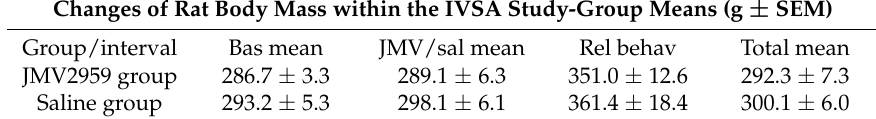
Table 1. Changes of rat body mass within the IVSA study. The body mass changes are represented as group means (JMV2959 group N = 12, Saline group N = 8) during the chosen periods of the experiment as follows: mean of the last eight days before pretreatment (Bas mean), mean of the three pretreatment days (JMV/sal mean), the day of the relapse-like behavior test (Rel behav), mean of 8 baseline days + 3 pretreatment days + day of relapse-behavior testing (Total mean). Means of the rat groups are presented ± SEM. The statistical significances are described below the table. Changes of Rat Body Mass within the IVSA Study-Group Means (g ± SEM) Group/interval Bas mean JMV/sal mean Rel behav Total mean JMV2959 group 286.7 ± 3.3 289.1 ± 6.3 351.0 ± 12.6 292.3 ± 7.3 Saline group 293.2 ± 5.3 298.1 ± 6.1 361.4 ± 18.4 300.1 ± 6.0 Two-way ANOVA RM difference between JMV2959 vs. saline groups: F1,18 = 0.43, p = 0.519 (n.s.), effect of time: F11,198 = 33.45, p < 0.001 (difference of relapse-like behavior in both JMV2959 and saline groups vs. other parameters), time × group interaction: F11,198 = 0.17, p = 0.1 (n.s.); Baseline = mean of 8 days, JMV/sal = mean of 3 pretreatment days, Relapse-like behavior = 1 day, Total mean = 8 Bas + 3 JMV/sal + Rel behav = 12 days; JMV2959 group N = 12, Saline group N =